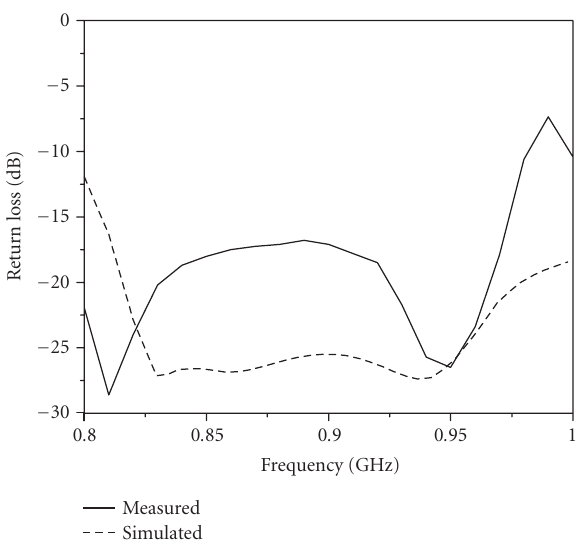
Figure 2: Measured and simulated return losses of the proposed